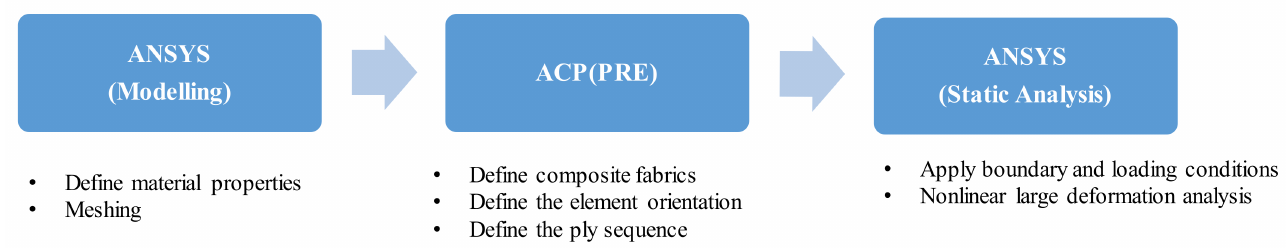
Figure 1. A process of ANSYS Composite